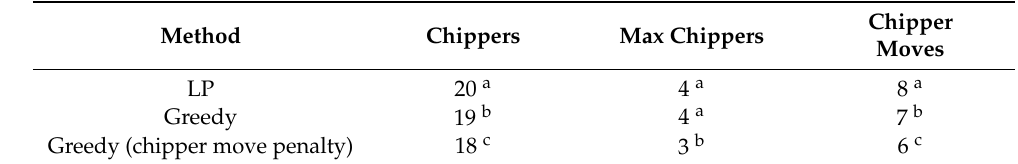
Table 6. Comparison between the LP solver and Greedy algorithm results with and without a chipper move penalty. Only test criteria with significant differences are